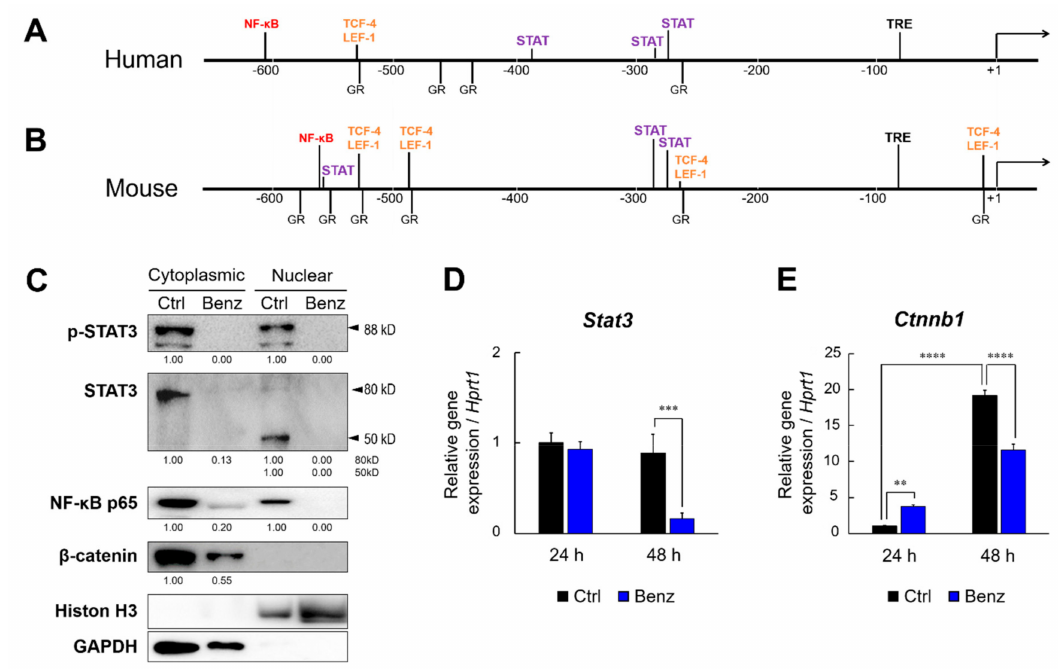
Figure 4. Benztropine reduces STAT, NF- κ B, and β -catenin in tumoroids. (A,B) Maps of MMP9 promoter regions in ( A ) humans and ( B ) mice. Binding sites for STAT, NF- κ B, TCF-4 / LEF-1, and the glucocorticoid receptor (GR) were mapped. ( C ) Western blot showing STAT3, NF- κ B p65 / RelA, and β -catenin in nuclear and cytoplasmic fractions of LuM1 tumoroids. Tumoroids were treated with 20 µ M Benz for 72 h. Phosphorylated STAT3 (p-STAT3) and unphosphorylated STAT3 were examined. Histone H3, a nuclear marker. GAPDH, a cytoplasmic marker. Densitometric readings for all western blots were calculated relative to the Ctrl. ( D, E ) RT-qPCR analysis for the mRNA levels of Stat3 and Ctnnb1 altered by Benz. LuM1 cells were treated with 20 µ M Benz for 24 h and 48 h under 3D culture condition. Mean ± SD, n = 3. ** P < 0.01, *** P < 0.001 and **** P < 0.0001 vs Ctrl. mRNA levels were normalized with Hprt1